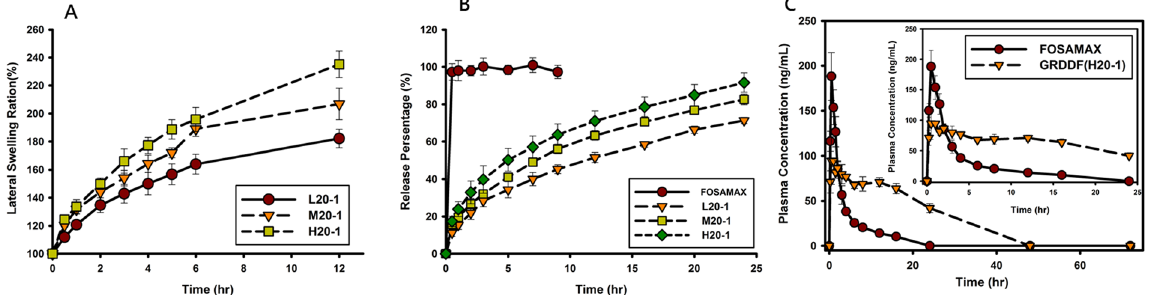
Figure 5. Lateral swelling abilities of ( A ) and dissolution profiles of alendronate in simulated gastric fluid (SGF) from ( B ) FOSAMAX and tablets prepared with ring-opened polyvinyl pyrrolidone ( ro PVP)/chitosan (CS) hydrogels composed of ro PVP complexed with either low molecular weight (Mw) CS, medium Mw CS, or high Mw CS at a ro PVP:CS ratio of 20:1. ( C ) Plasma alendronate concentration profiles after administration of